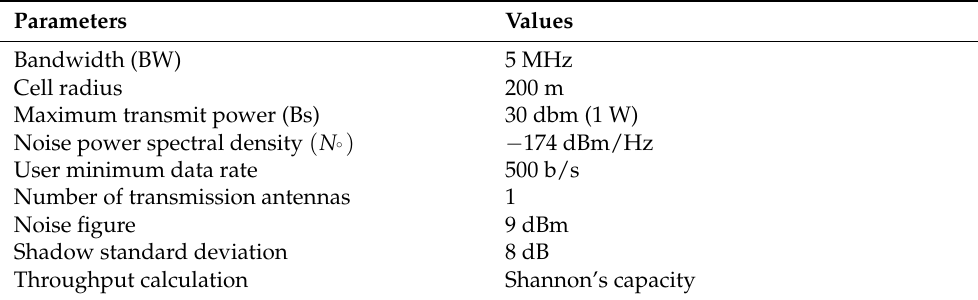
Table 3. Parameters of the system